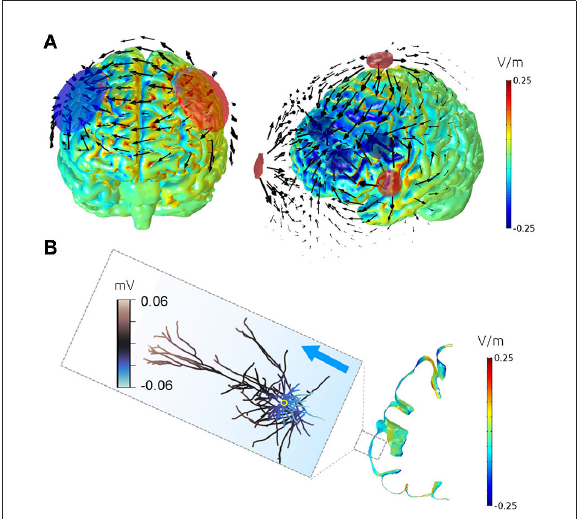
FIGURE1 Simulation of tES-induced electric field on realistic brain model. (A) Electric field on a realistic brain model, generated by a bipolar montage with large sponge electrodes (left) and a multichannel montage employing six smaller electrodes (right). Cathodes are shown in blue, and anodes in red. Fields are shown for a total applied stimulation current of 1mA for the bipolar and 4mA for the multichannel montages. The colormap represents the component of the electric field directed perpendicularly to the cortical surface (or normal electric field, scale in V/m). The arrows display the current density field in the brain (not in scale). In our convention, the cortical normal vector points from the cortex surface to deeper brain regions, therefore outward currents give rise to negative values of the normal electric field component (in blue) and inward currents to positive values (in red). Normal electric fields are strongest under the electrode and in regions where the cortical gyration aligns the cortical column with the electric field between the electrodes. In multielectrode focal montages (right figure), the outward fields are particularly predominant under the cathodes. (B) Normal electric field and induced soma polarization for a total applied stimulation current of 1mA. Detail of the membrane polarization induced by an electric directed outwardly from the cortex on a realistic pyramidal neuron. The neuron morphology was reconstructed from Blue Brain Project. It is approximately located in the area in the dashed box, oriented perpendicularly to the cortex and exposed to an electric field value of 0.15 V/m along its axo-somatic axis and directed outwardly (blue arrow). The electric field causes a net polarization, or hyperpolarization, of the soma (located inside the yellow circle) of about − 0.06mV from the resting potential.